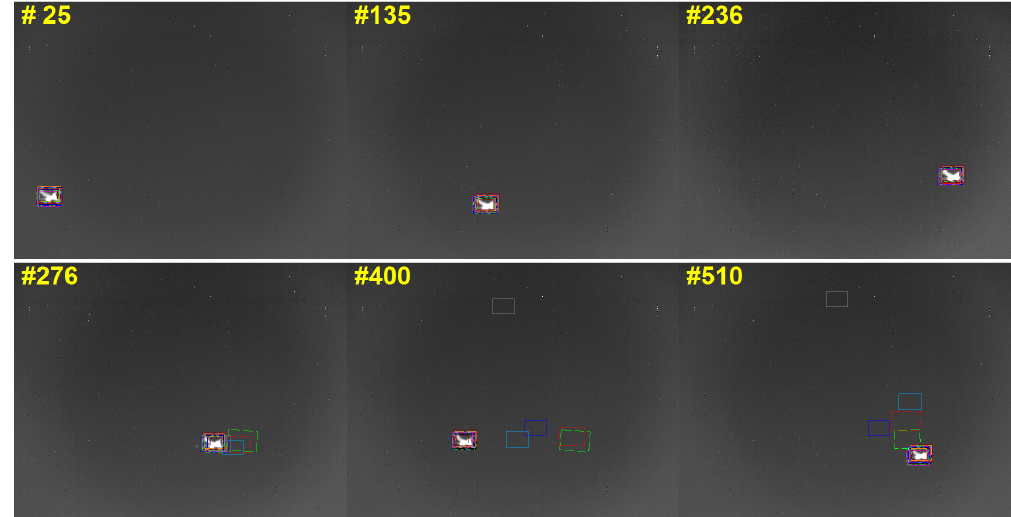
Figure 16. Tracking results of real infrared